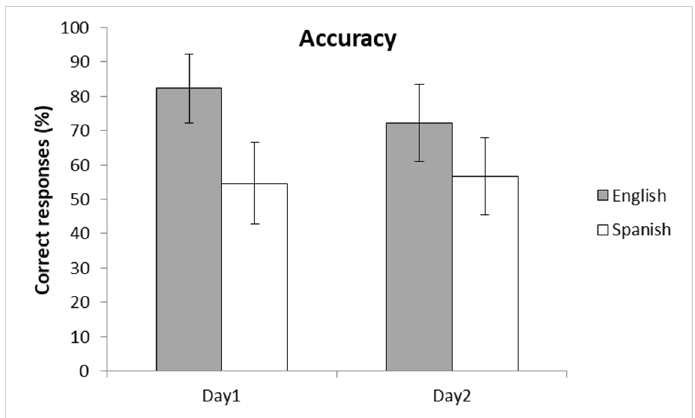
Figure 1. Mean accuracy (percentage of hits) in the block-container association task divided by the language of instruction. Error bars indicate 95% confidence intervals.